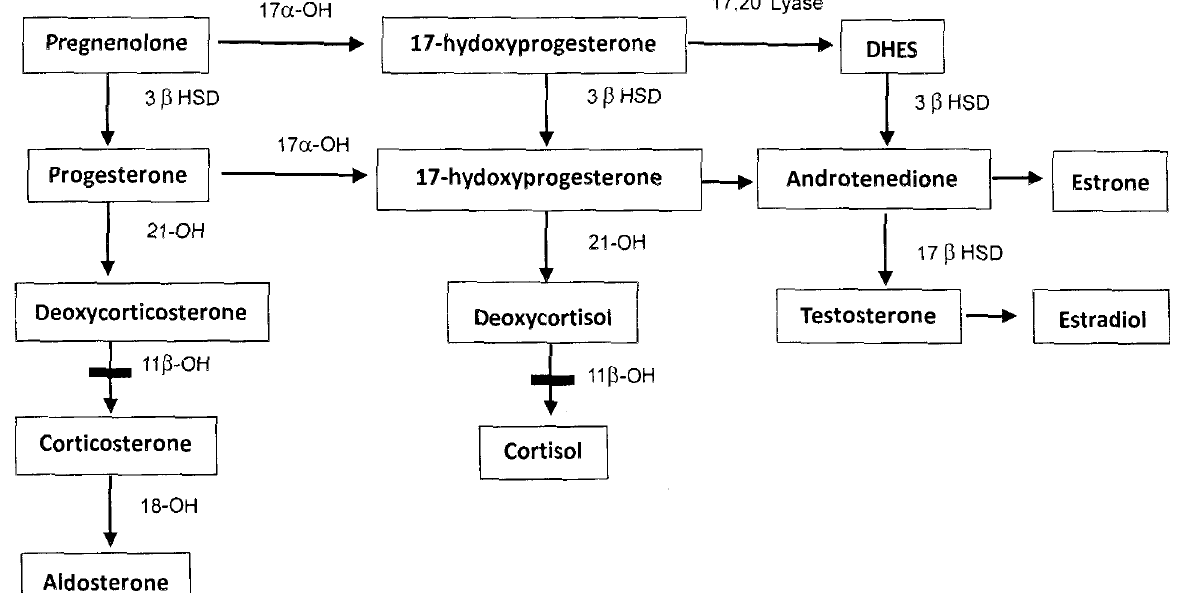
Figure 1. Adrenal steroid synthesis. Deficiency in 11 βββββ -hydroxylase (CYP11B1) results in accumulation of DOC and consequent hypertension; increased androgen